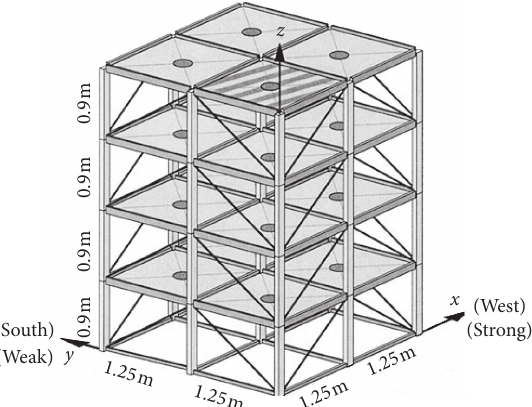
Figure 4: Diagram of analytical model with strong and weak